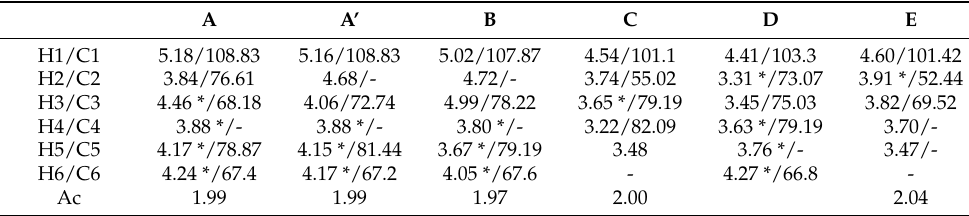
Table 2. Chemical shifts (ppm) of 1 H and 13 C NMR signals in tunic